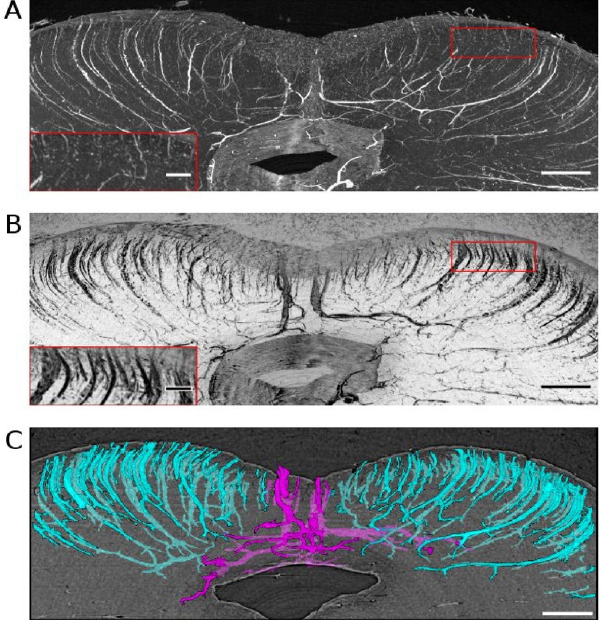
Figure 3. Vasculature from 4.94 µm voxel size phase-contrast microtomography. ( A ) Maximum intensity projection of sample 1 with zoomed inset showing the appearance close to the tissue surface. ( B ) Minimum intensity projection of sample 1 with zoomed inset from the same region as in A. Note the improved conspicuity of the vessels close to the tissue surface. ( C ) Three-dimensional view of the collicular vessels after segmentation. Peripheral collicular vessels are shown in cyan and central collicular vessel are shown in magenta. Scale bars = 1 mm. Scale bars of insets = 0.5